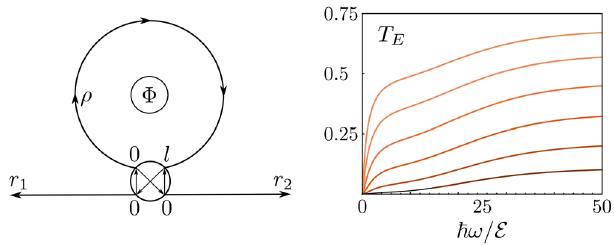
FIG. 7. Scattering theory of a quantum generator. The system consists of two leads, an ideal beam splitter, and a loop with length l , which is subject to the magnetic flux Φ . The leads and the loop are parametrized in terms of the coordinates r 1 ; r 2 ∈ ½ 0 ; ∞ Þ and ρ ∈ ½ 0 ; l (cid:3) . Incoming waves on the leads 1 and 2 enter the loop at the positions ρ ¼ 0 and ρ ¼ l , respectively; clockwise and counterclockwise propagating waves on the loop exit at the positions ρ ¼ l and ρ ¼ 0 and become outgoing waves on the leads 1 and 2, respectively. The plot shows how the transmission function (D16b) depends on the driving frequency ω , i.e., the rate at which the magnetic flux Φ changes, for E= E ¼ 2 0 = 10 ; … ; 2 5 = 10 from top to